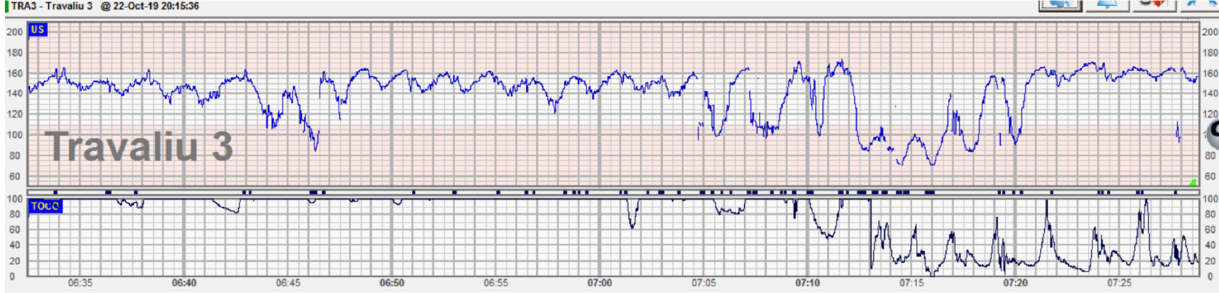
Figure 3. Prolonged deceleration associated with umbilical cord prolapse. This case is about a primiparous patient in the latent first stage of labor. She was admitted for regular